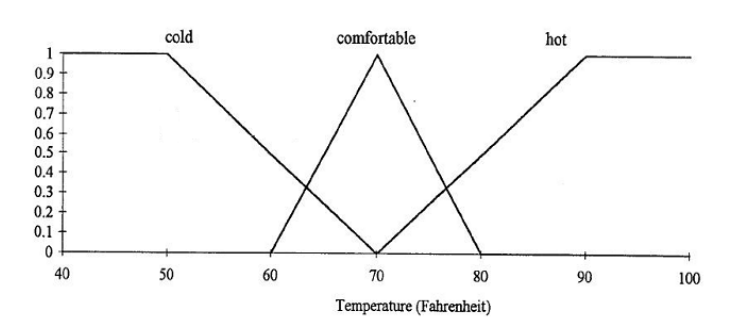
Figure 4. Membership function